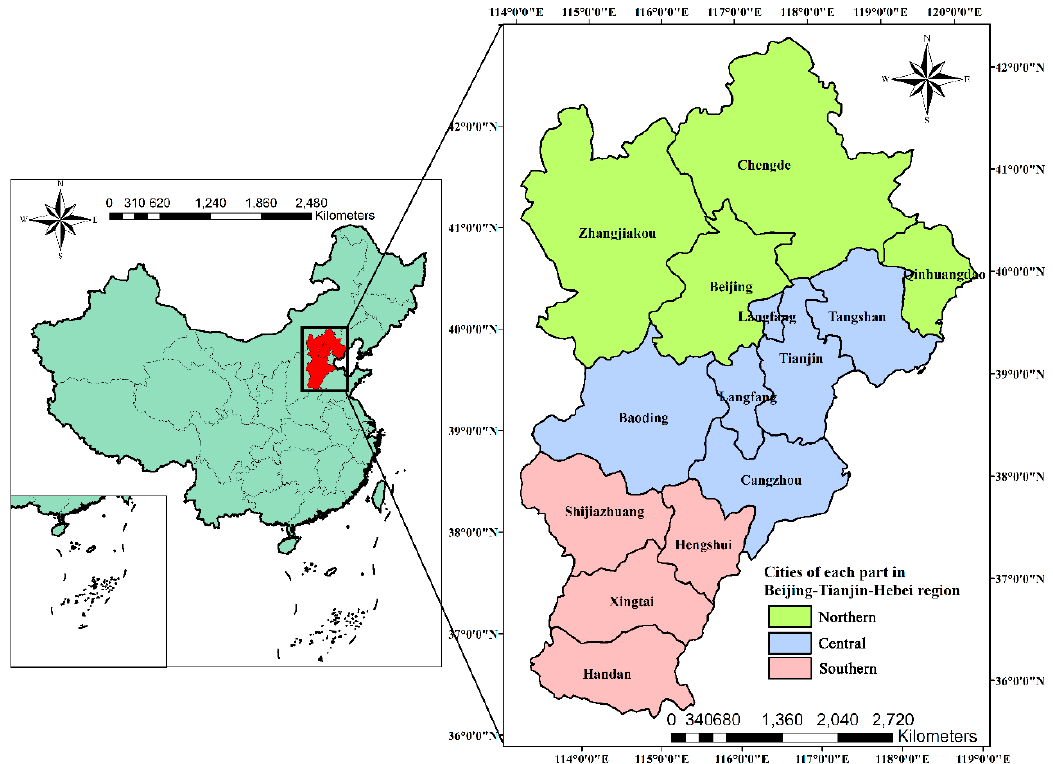
Figure 1. Beijing–Tianjin–Hebei (BTH) urban agglomeration, with its location in China, shown in red in the left panel; the right panel shows the cities in the region. To further explore surface urban heat island (SUHI), the area was divided into three parts: Beijing, Zhangjiakou, Chengde, and Qinhuangdao in the northern part, shown in green; Tianjin, Langfang, Baoding, Tangshan, and Cangzhou in the central part, shown in blue, Shijiazhuang, Hengshui, Xingtai, and Handan in the southern part, shown in pink.